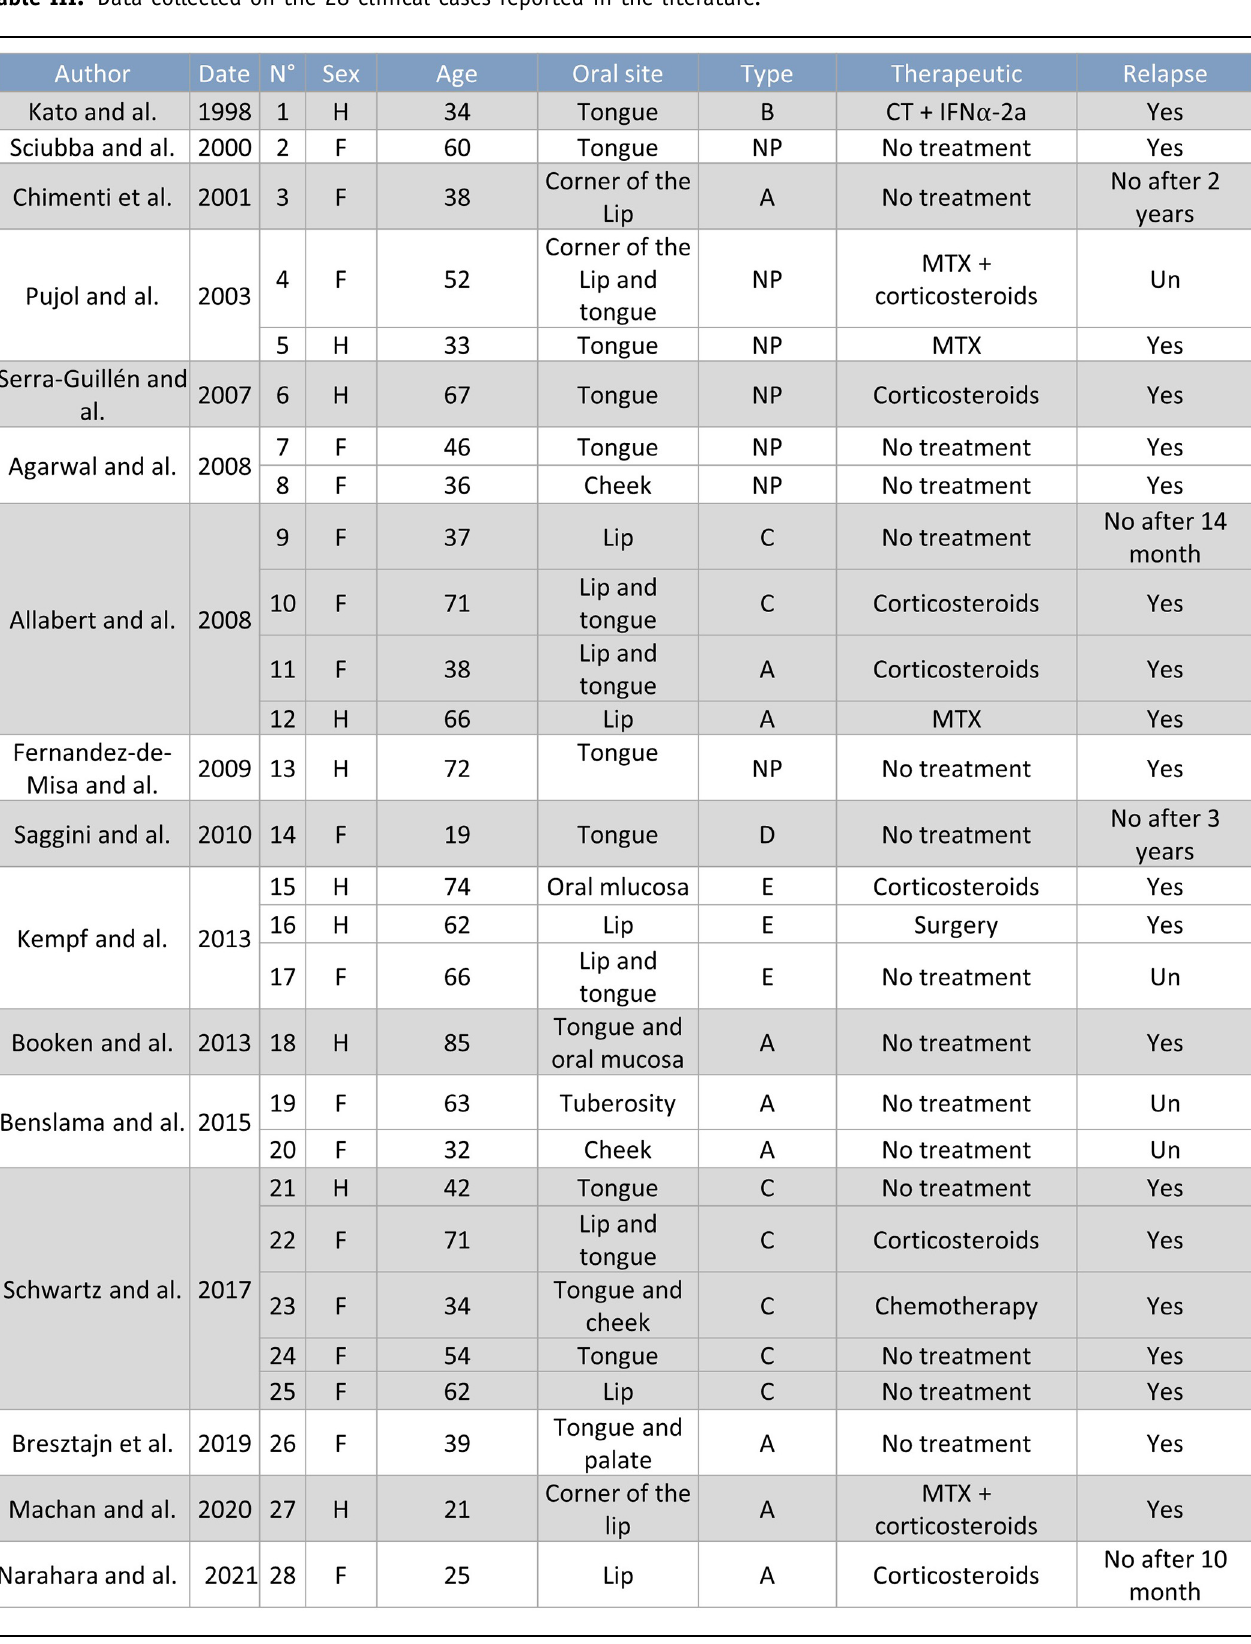
Table III. Data collected on the 28 clinical cases reported in the